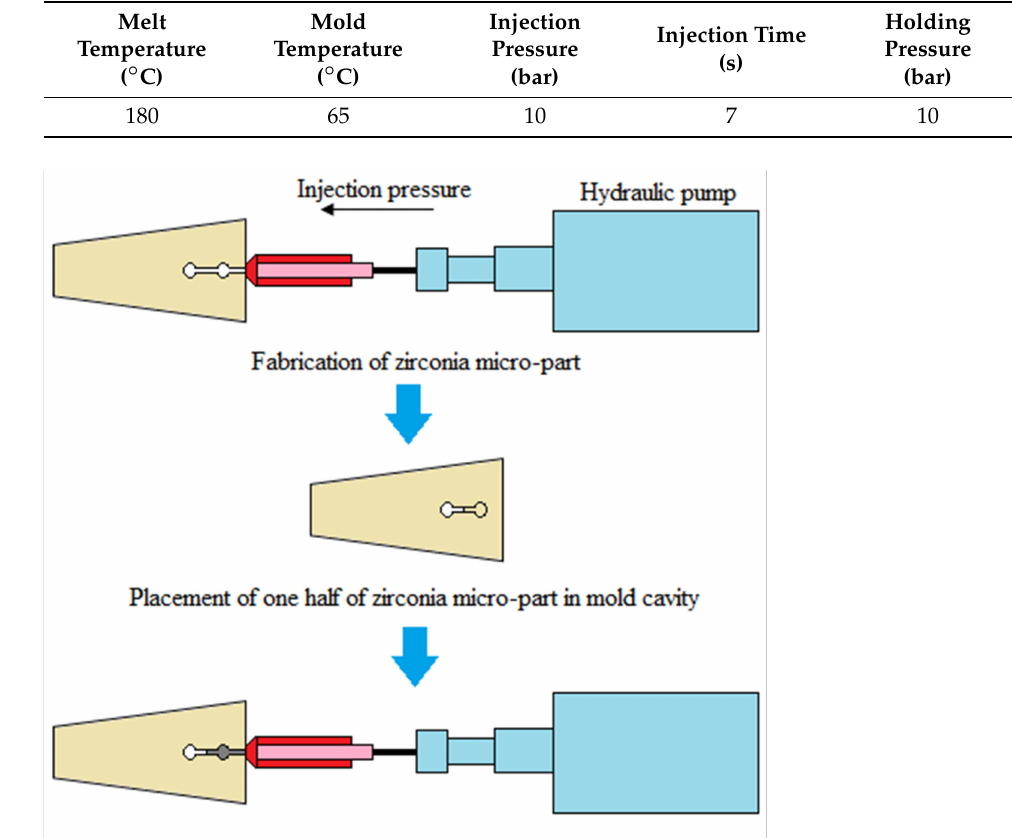
Table 2. Micro-injection molding parameters.